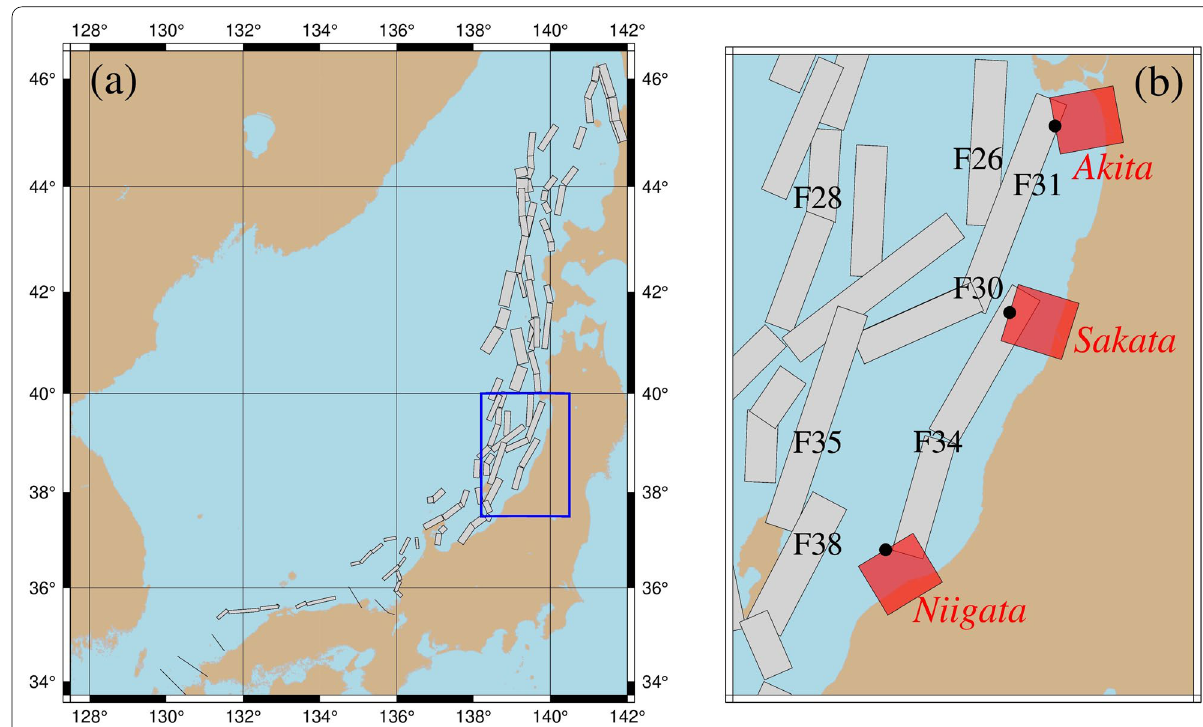
Fig. 1 Overview of tsunami sources generated by earthquakes (gray squares) proposed by MLIT (2014). a Over the Japan Sea; b the area specified by the blue square in ( a ), and the red squares indicate computation domains for the inundation